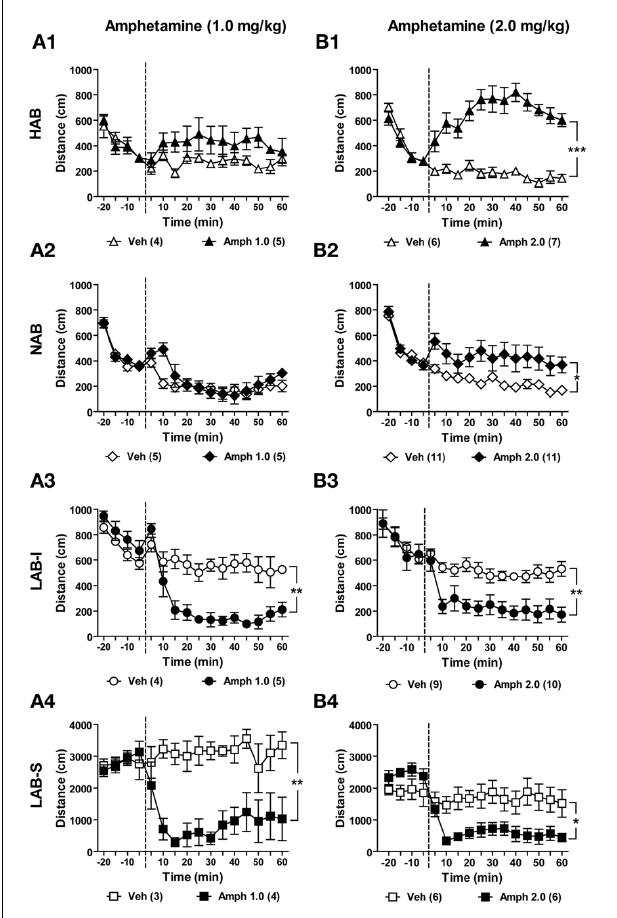
FIGURE 13 | Amphetamine induced a paradoxical calming effect on locomotor activity in LAB mice. Mice of each line were randomly assigned to control (Veh) and amphetamine (Amph) groups. After 20min of OF exposure, HAB, NAB, LAB-I, and LAB-S mice were treated with either saline or amphetamine at 0min (dashed lines) and distance traveled was continuously measured for 60min. Amphetamine of two different doses (1.0 and 2.0mg/kg) were administered to separate groups of animals. (A1–A4) Treatment with amphetamine (1.0mg/kg) did not affect the distance traveled in HAB and NAB mice. However, locomotor activity in LAB-I and LAB-S mice was attenuated by amphetamine at lower dose (1.0mg/kg). (B1–B4) Treatment with amphetamine (2.0mg/kg) induced strong increases in HAB, intermediate increases in NAB, and decreases in both LAB-I and LAB-S mice in distance traveled. Mean ± SEM. ∗∗∗ p < 0 . 001; ∗∗ p < 0 . 01; ∗ p < 0 . 05 compared with Veh (ANOVA followed by post-hoc Newman–Keuls